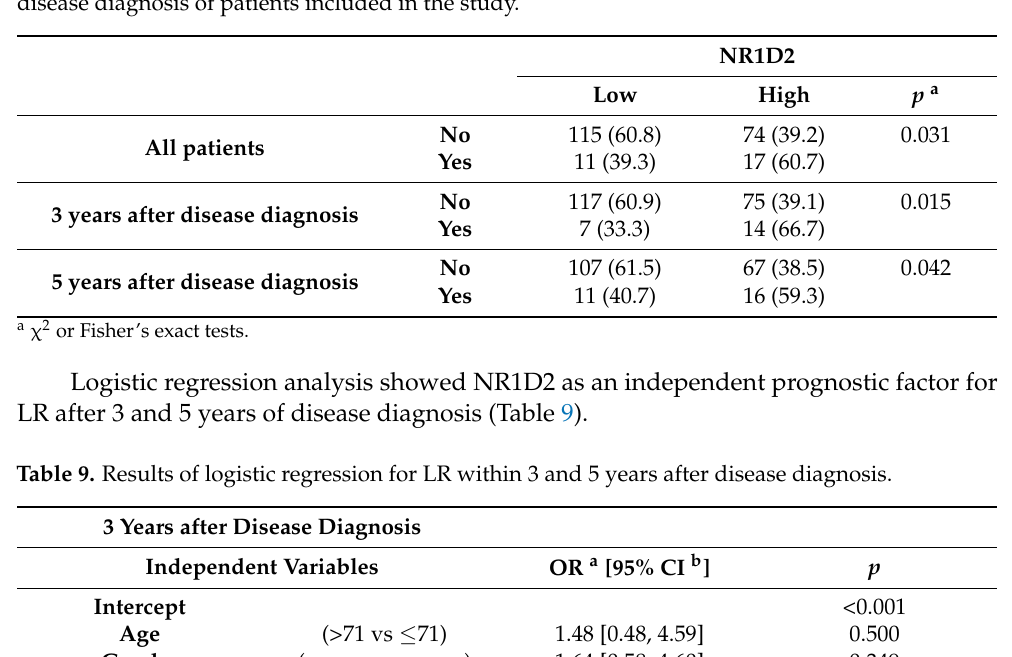
Table 8. Relationship between expression levels of circadian proteins and development of LR after